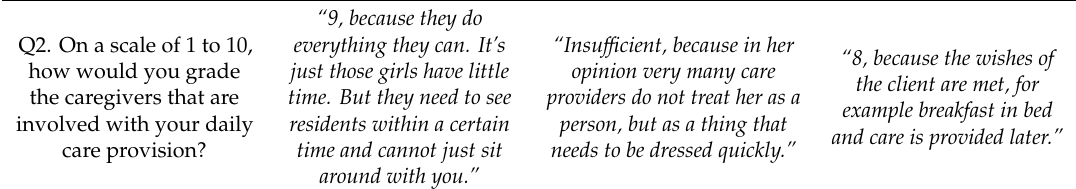
Table A2. Example answer output Connecting